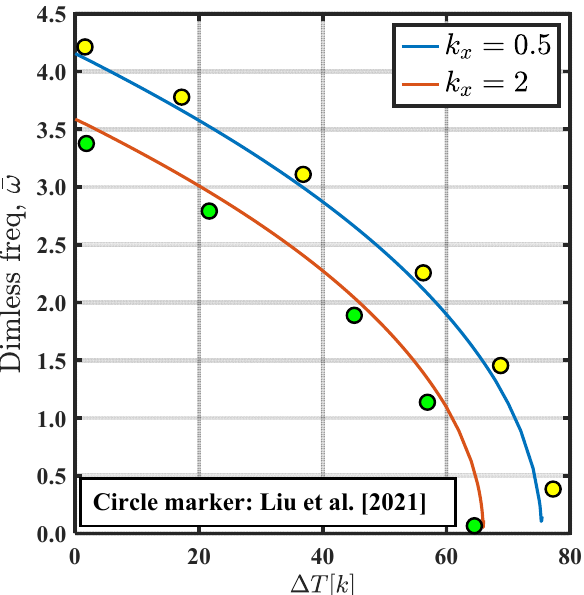
Figure 2. Comparison of the dependency of the dimensionless fundamental frequency of the beam at different temperature differences ∆ T under LTR for k x = ( 0.5, 2 ) , k z = 0.5, lcs = 0.25 h .